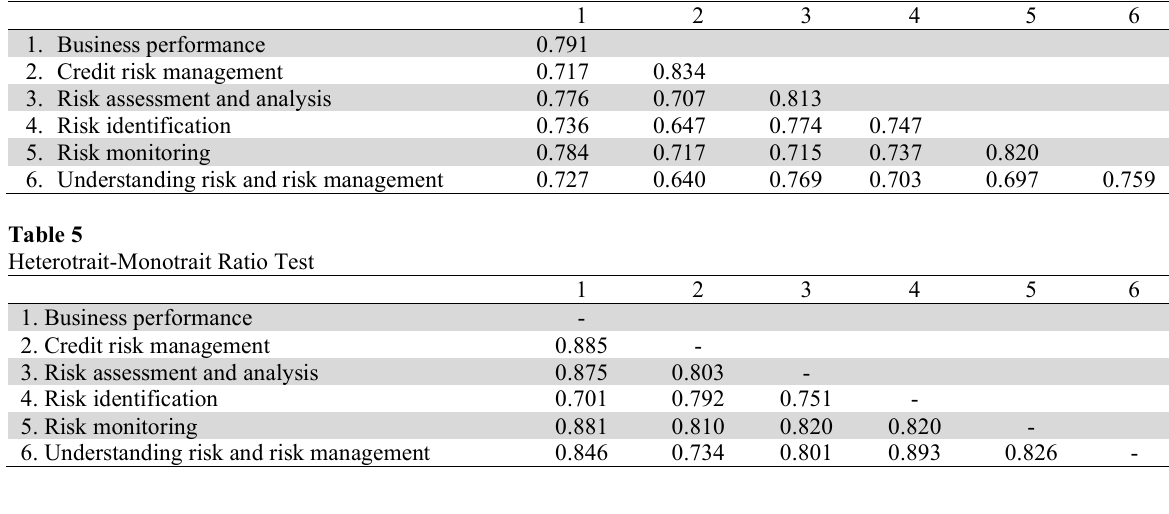
Fornell and Larcker Criterion Test